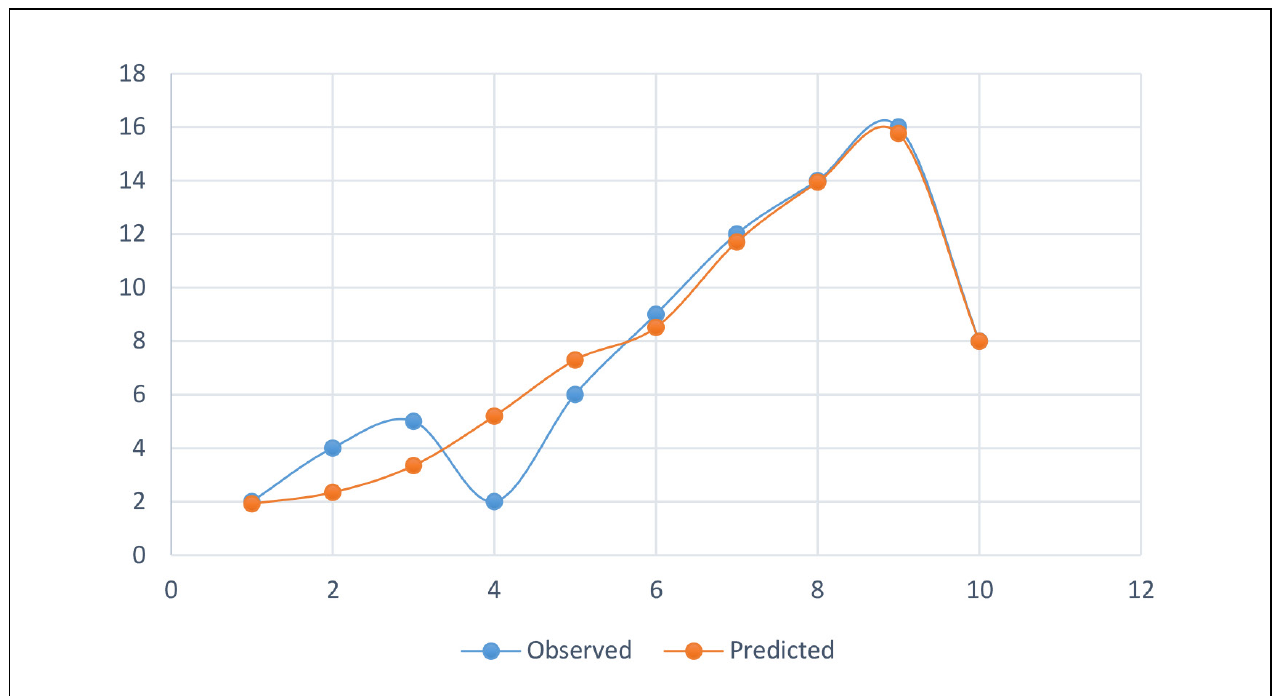
Fig. 4 – The calibration of the logistic regression model for predicting cardiac surgery-associated acute kidney injury (CSA-AKI) in the matched cohort.